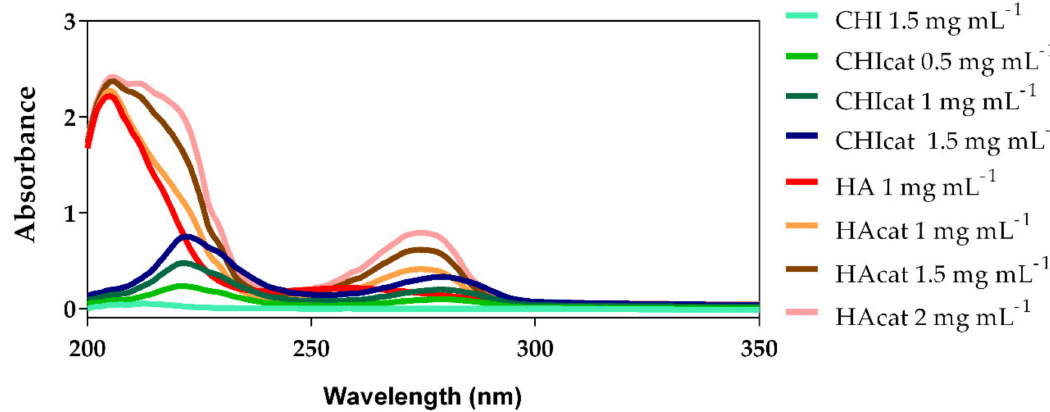
Figure 1. UV-Vis spectra of chitosan (CHI) and hyaluronic acid (HA), catechol-conjugated CHI (CHIcat) and catechol-conjugated HA (HAcat) ( λ = 200–350